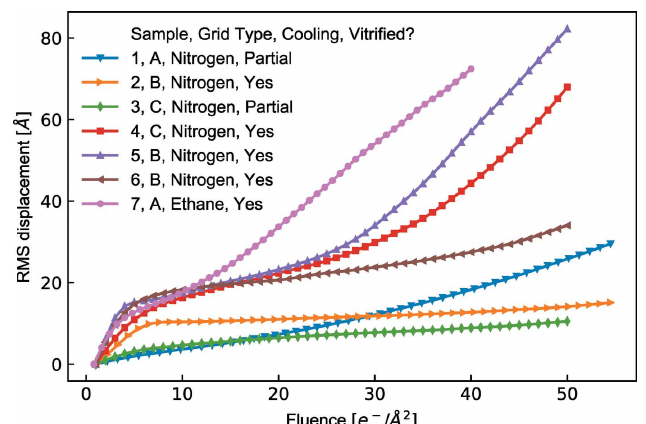
Figure 5 Drift-corrected RMS particle displacement versus fluence, all measured using the same cryo-TEM. Grid type A is Quantifoil UltraAuFoil 1.2/1.3, Au foil with 1.2 m m holes on Au grids; type B is prototype Au foil with 1.2 m m holes on a Cu grid; type C is prototype Au foil with 1.2 m m holes on an Au grid. Samples 1–6 were cooled in boiling LN 2 , and sample 7 was cooled in ethane using a Vitrobot Mark IV. Samples 1 and 3 were partially vitrified; most holes gave good particle images but showed local ice, confirmed by appreciable intensity at ice ring positions in image FFTs. Samples 2 and 3–7 were largely vitrified with only a small minority of frames showing evidence of